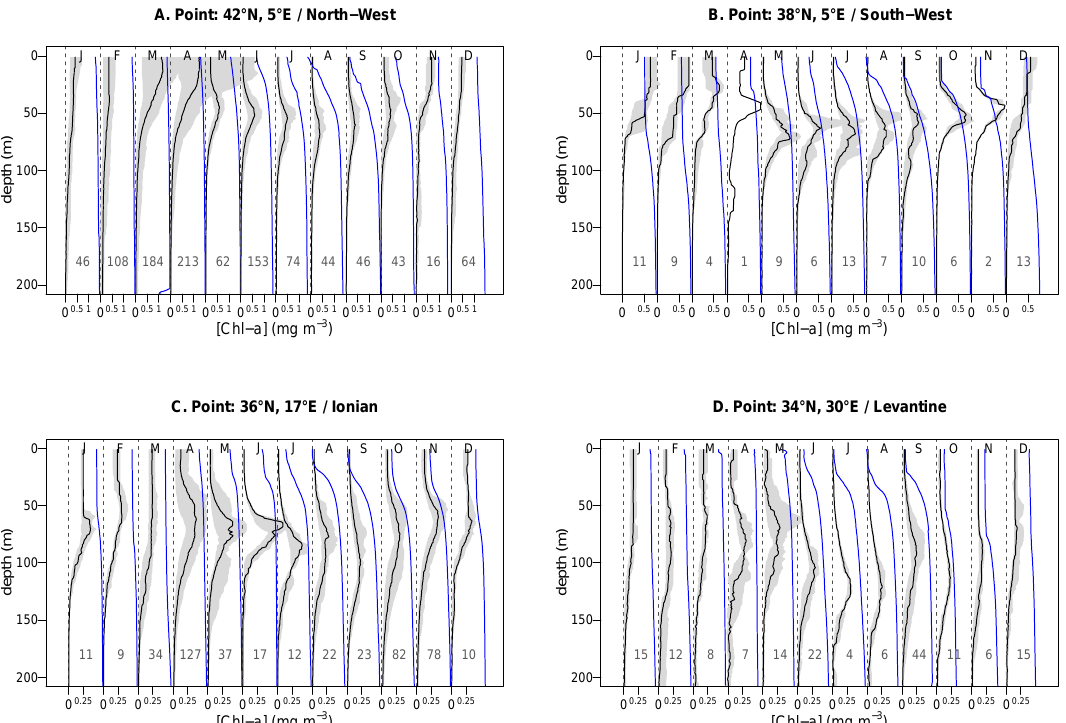
Figure 3. Climatology of [Chl a ] vertical profiles (black lines) for four points of the Mediterranean Sea (see yellow diamonds in Fig. 1). All profiles located within a 4 ◦ × 4 ◦ box centered on indicated positions were retained. The median value for each month is the black line. The grey zone indicates the 0.1-quantile–0.9-quantile range. Numbers below climatological profiles indicate the number of available data profiles used to compute them. Normalized average water density profiles are superimposed (blue